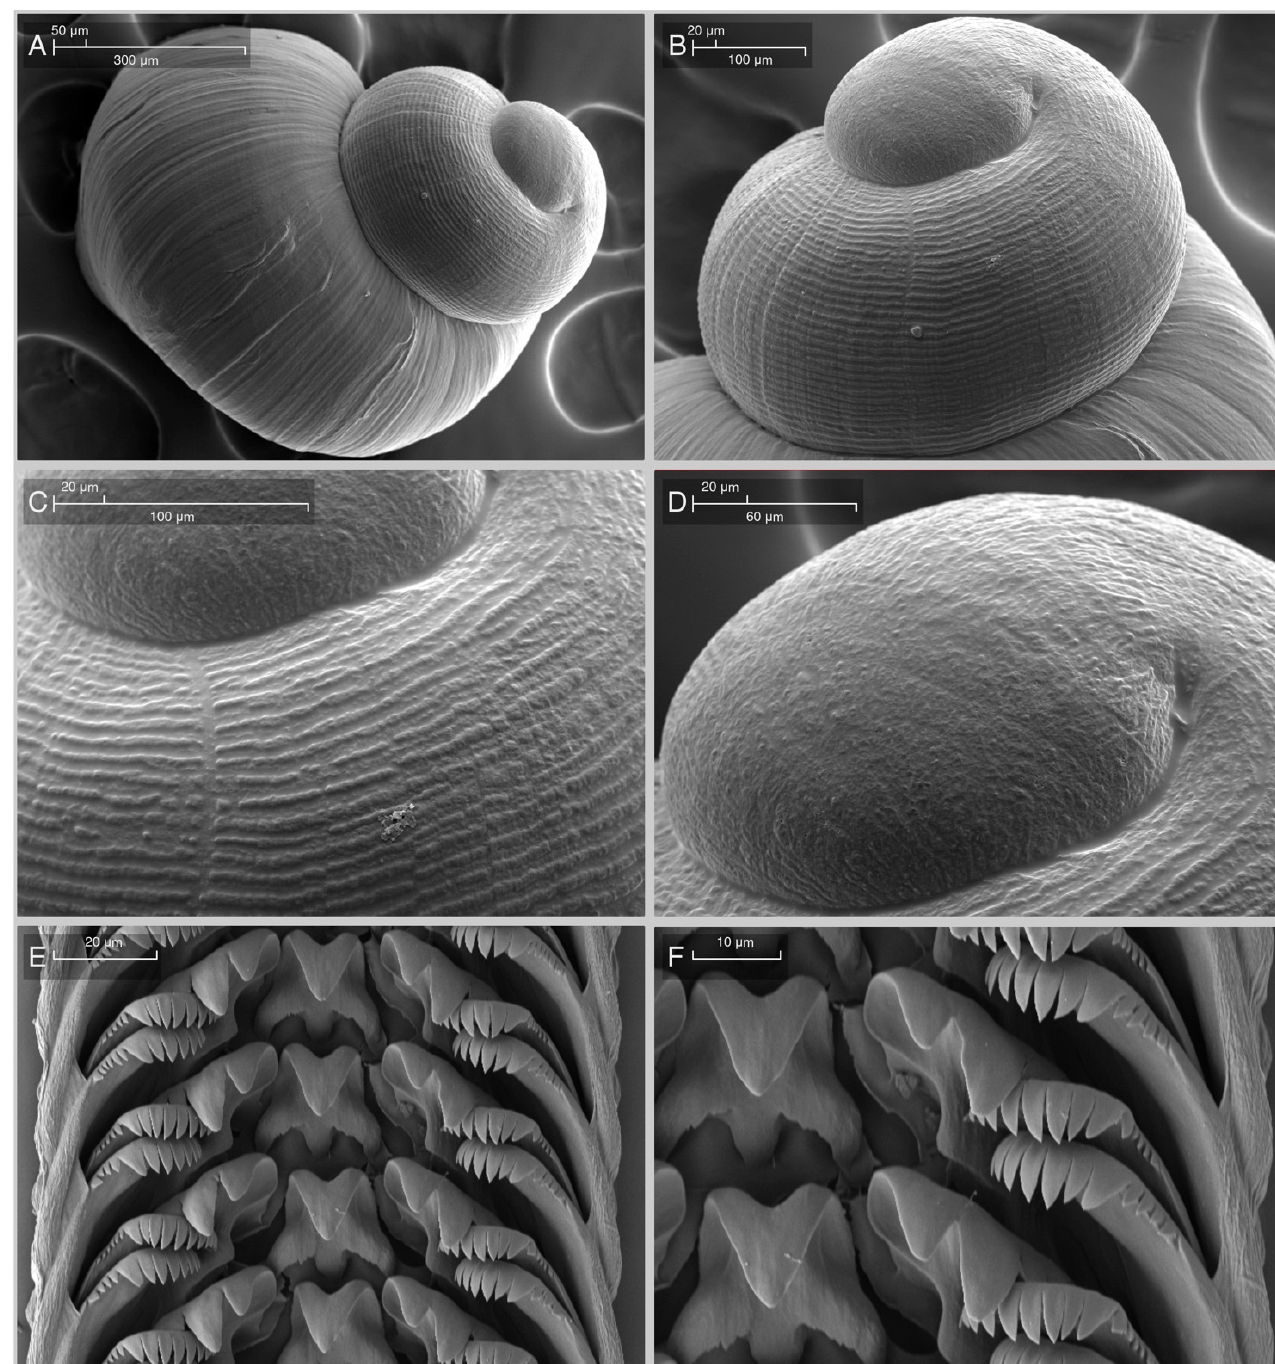
Figure 3. Morphological details of Provanna annae sp. nov. ( A – D ), protoconch, LV75-4/1 (same specimen as Figure 2D); ( E , F ), radula, paratype. Holotype measurements: shell height = 5.0 mm, aperture height = 2.8 mm, last whorl height = 4.14 mm, shell width = 3.3 mm, and aperture width = 2.16 mm Animals are yellowish. Proboscis large and broad; tentacles thin, thickening in their basal parts, several times longer than proboscis. Pigmented eyes absent. Males lack penis. Radula comprises approximately 40 mature rows. Central tooth with one narrow cusp (Figure 3E,F). Lateral teeth with 3–4 broad cusps; marginal teeth spoon-like with numerous narrow denticles. Digestive tract without noticeable thickening that would cor- respond to the stomach. Pellets brownish, barrel-shaped, non-homogenous (Figure 4A). Morphologically, it is possible to distinguish fragments of diatom shells (Figure 4B,C,E,F) and rod-shaped structures that are considered as bacteria (Figure 4D). Energy Dispersive